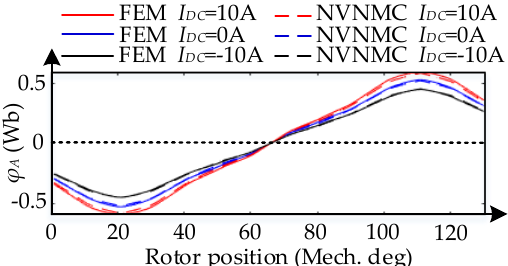
Figure 9. Flux linkage of phase A with different DC currents.